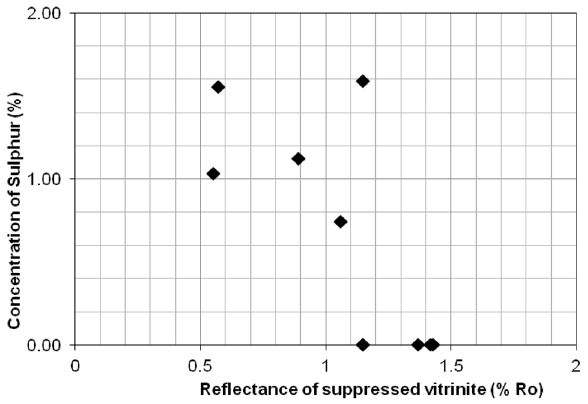
o to show the relationship